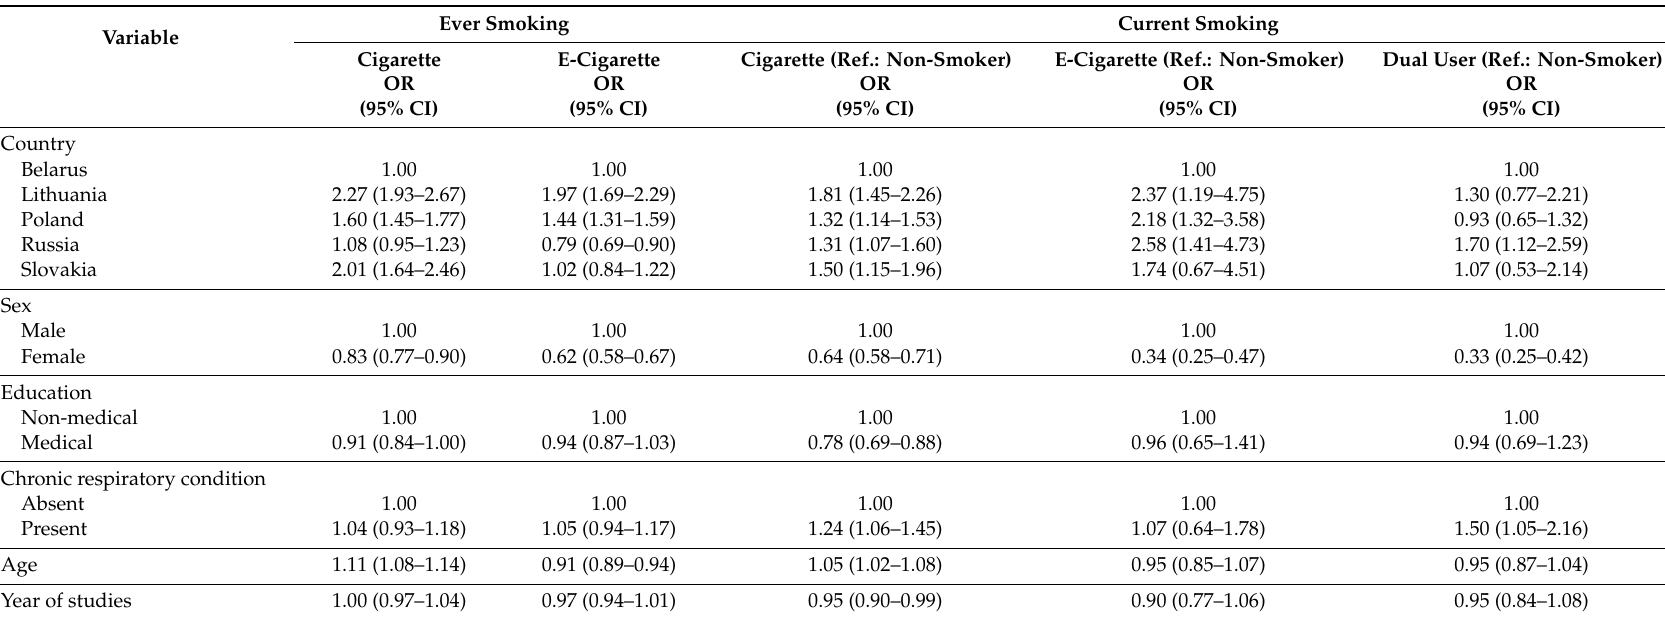
Table 5. Adjusted * associations between personal characteristics and smoking